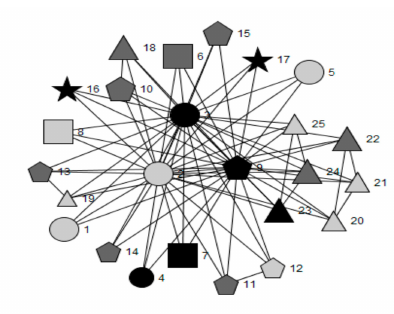
Figure 2. Net-map of wellbeing lead’s ego network for Highbridge